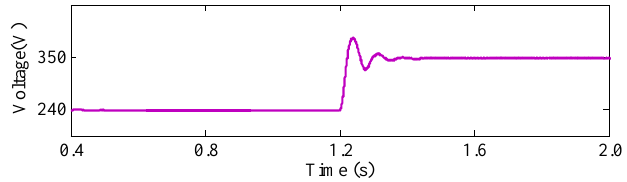
Figure 15. DC bus voltage under the transition from Mode II to Mode I.